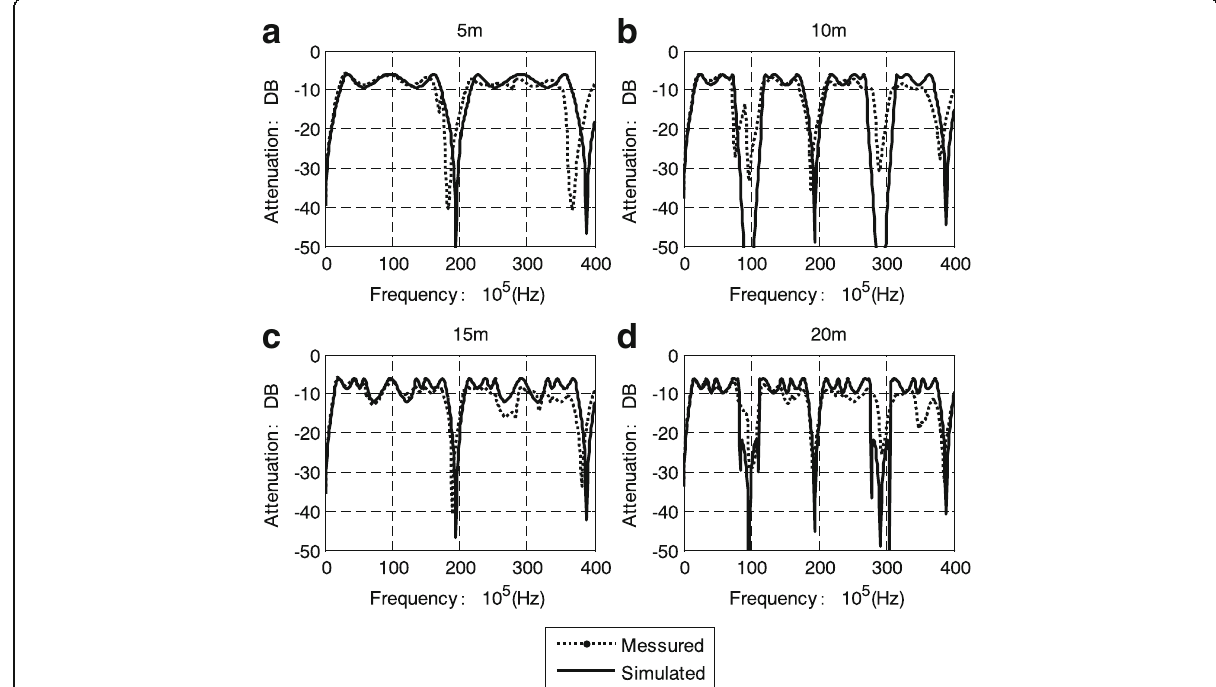
Fig. 19 Voltage transmission amplitude-frequency characteristic for various trunk lengths ( a ) 5m ( b ) 10m ( c ) 15m ( d ) 20m